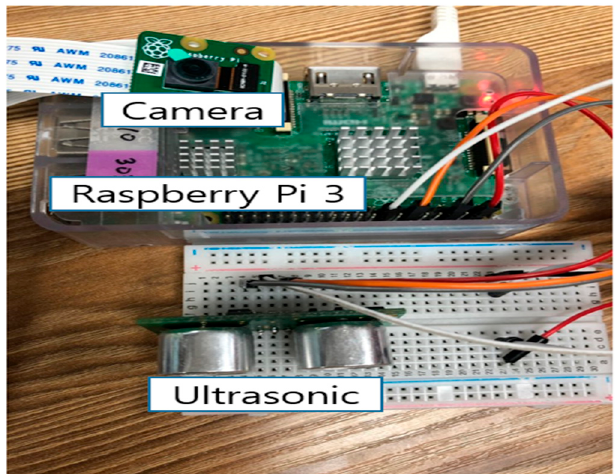
Figure 6. Experimental equipment (Raspberry Pi3, Ultrasonic, Camera, Raspberry Pi Foundation, Cambridge, UK).